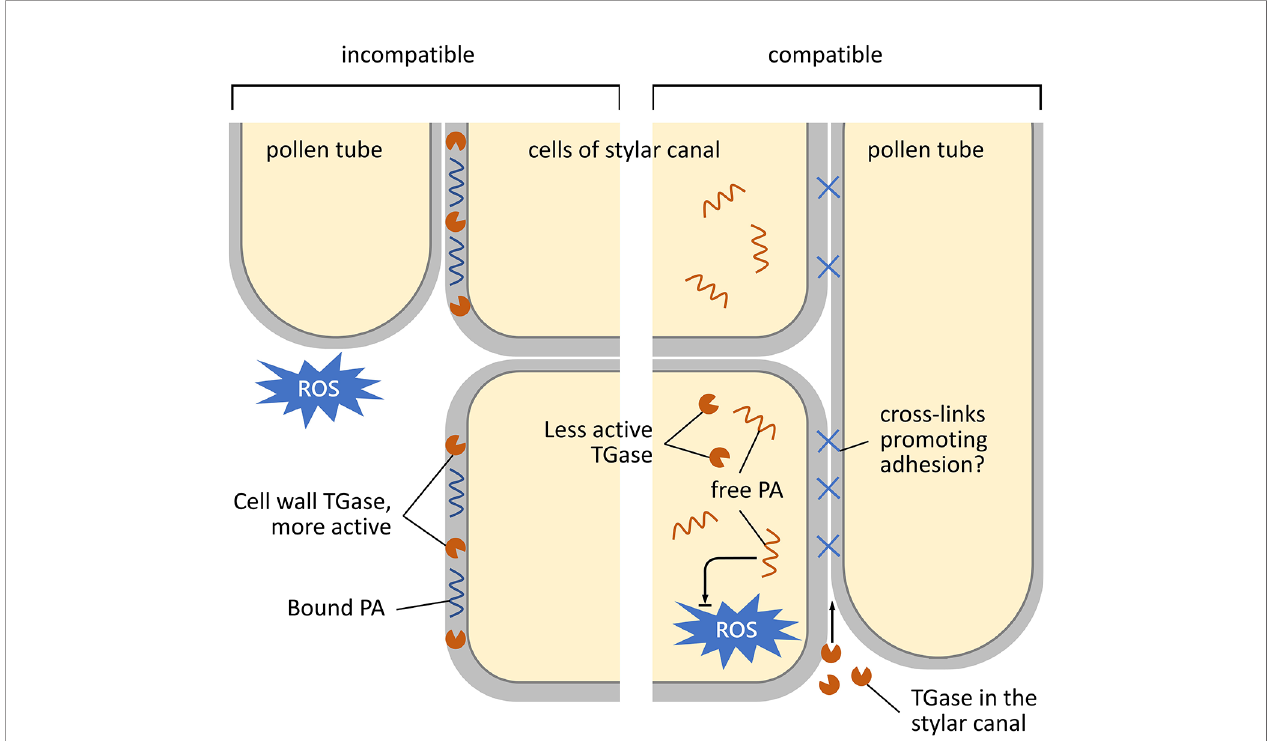
FIGURE 7 | Schematic representation of the growth and adhesion of pollen tubes during their pathway through the stylar canal. Left, incompatible condition; right, compatible condition. In the case of the incompatible reaction, TGase accumulates in the cell walls of cells of the stylar canal. Here, TGase is enzymatically active and results in a higher percentage of bound PAs. It is assumed that bound PAs serve to strengthen the cell wall by preventing damage to the stylar cells during the rejection of pollen tubes (caused, for example, by an increase in ROS). In the compatible situation (right), TGase is located in the cytoplasm of stylar cells in a less or non-active form. Therefore, PAs are more in the free form and could serve to counteract any increase in ROS. The TGase present in the stylar canal would in this case play a role in promoting adhesion between stylar cells and pollen tubes in order to promote